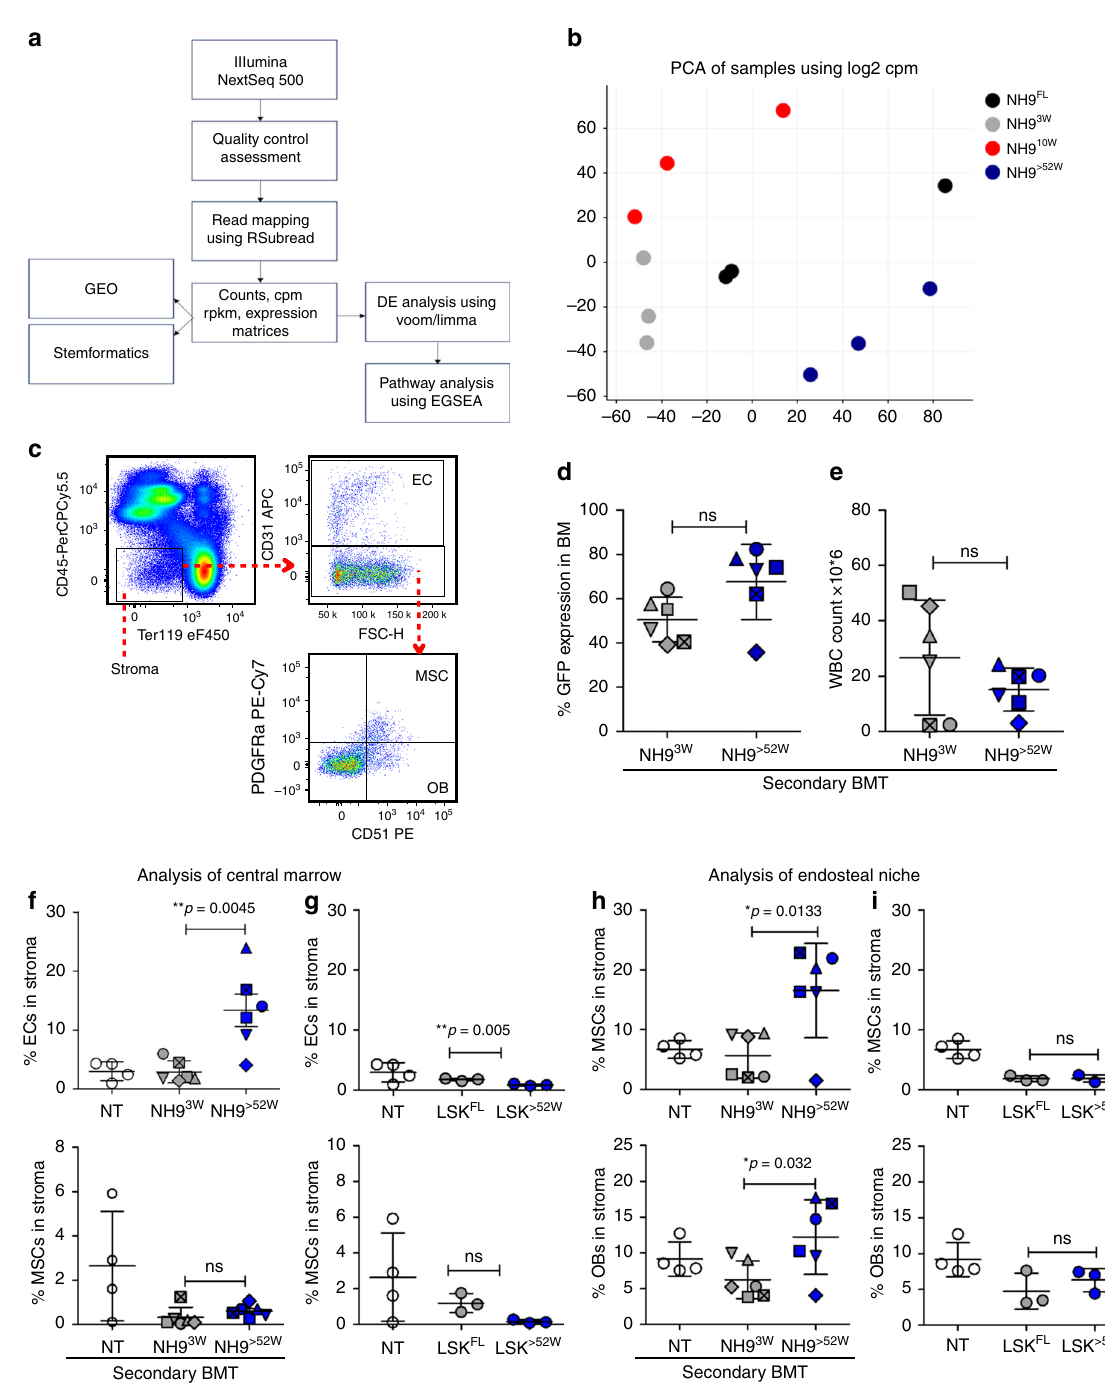
Fig. 4 Differential regulation of the BM niche by >52w and 3w AML. a Schematic overview of RNA seq data acquisition and analysis. b Plot of principal component analysis of gene expression in NH9 FL , NH9 3w , NH9 10w and NH9 >52w myeloid leukaemias, n = 3 in each group. c Flow cytometric gating strategy used to identify endothelial cells (EC), mesenchymal cells (MSC) and osteoblasts (OB) in the stroma (CD45 − Ter119 − ). Leukaemic burden assessed by d %GFP in BM and e WBC count. Analysis of percentage ECs (top) and MSCs (bottom) in the stroma of central marrow of mice transplanted with f NH9 + AML blasts or g healthy LSKs of foetal (LSK FL ) or >52w (LSK >52W ) origin. Analysis of percentage OBs (bottom) and MSC (top) in the stroma of the compact bone of mice transplanted with h NH9 + AML blasts or i LSK FL or LSK >52W . d – i Graphs depict individual values with mean ± s.d. of mice transplanted with leukaemic blasts from NH9 3W ( n = 13) or NH9 >52W ( n = 9) (only mice with >30% GFP in the bone marrow are included, and individual mice are indicated with different symbols on the graphs), and LSK FL ( n = 4) or LSK >52w ( n = 4) from healthy mice. NT not transplanted ( n = 4). Signi fi cance determined by Student ’ s t -test, * p < 0.05, ** p <